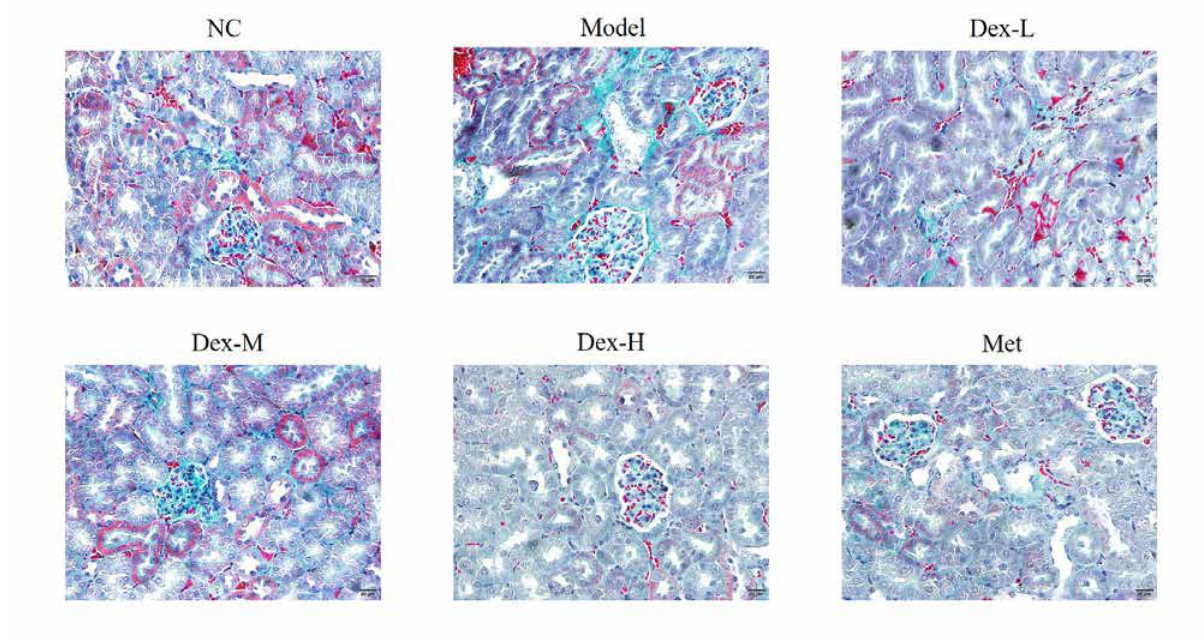
Figure 2: The Collagen fiber of different groups in kidney tissues by Masson staining (400×). NC: normal control group; Model: DN model group; Dex-L: Dex low-dose treated group; Dex-M: Dex medium-dose treated group; Dex-H: Dex high-dose treated group; Met: Metformin treated group